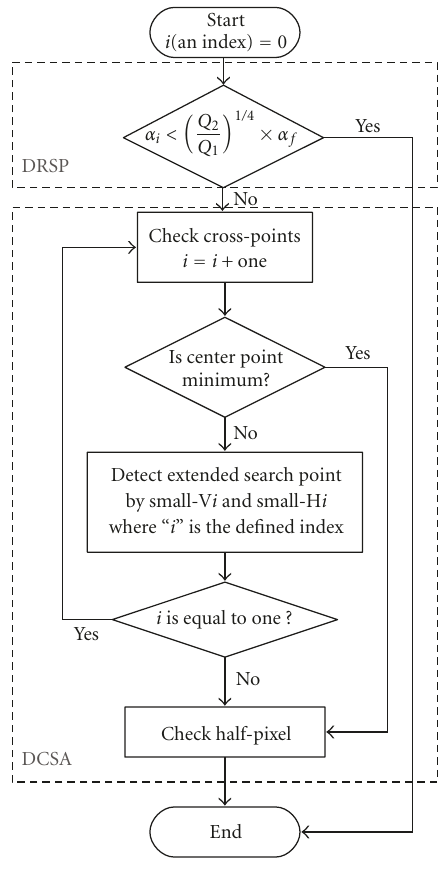
Figure 14: Flow chart of the proposed